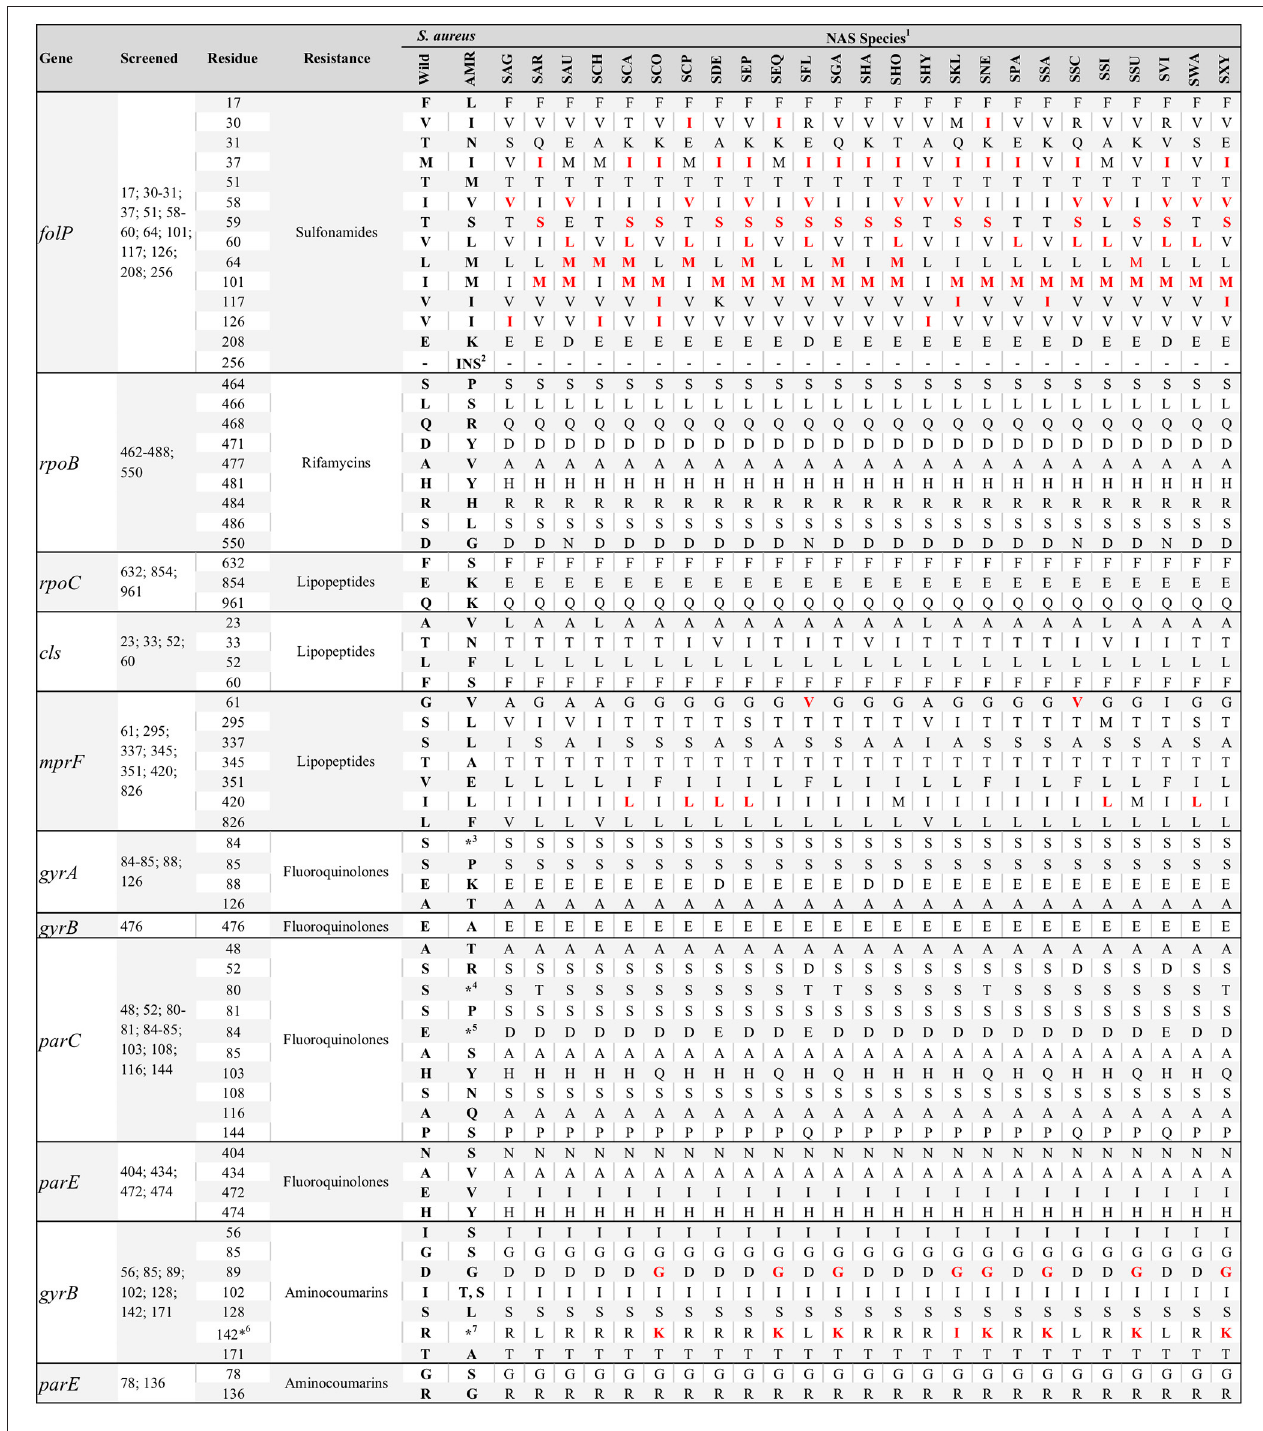
FIGURE 3 | Consensus of residue composition of genes associated with drug-specific antimicrobial resistance for various non- aureus staphylococci species (NAS). Positions screened per gene deduced amino acid sequences, in addition to S. aureus wild and resistance-associated residues, are also presented. Presence of a red residue for a particular species indicates residues associated with antimicrobial resistance in Staphylococcus spp., according to the literature. 1 SAG, S. agnetis ; SAR, S. arlettae ; SAU, S. auricularis ; SCA, S. capitis ; SCP, S. caprae ; SCH, S. chromogenes ; SCO, S. cohnii ; SDE, S. devriesei ; SEP, S. epidermidis ; SEQ, S. equorum ; SFL, S. fleuretti ; SGA, S. gallinarum ; SHA, S. haemolyticus ; SHO, S. hominis ; SHY, S. hyicus ; SKL, S. kloosii ; SNE, S. nepalensis ; SPA, S. pasteuri ; SSA, S. saprophyticus ; SSC, S. sciuri ; SSI, S. simulans ; SSU, S. succinus ; SVI, S. vitulinus ; SWA, S. warneri ; SXY, S. xylosus ; 2 Two-residues insertion at position 256; 3 A, F, I, L, V, or Y; 4 F, I, L, V, or Y; 5 A, G, K, N, V, or Y; 6 Position 140 for NAS; 142 for S. aureus ; 7 K, I or S.